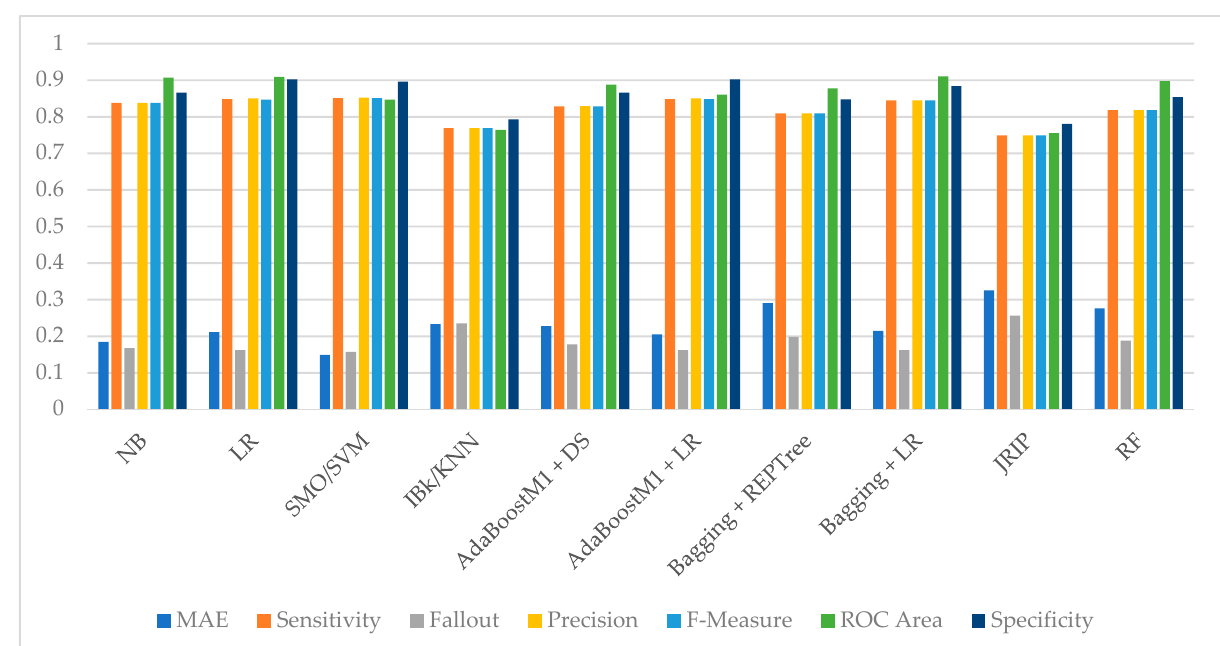
Figure 3. ROC curve of bagging with LR meta classifier using the full set of features.